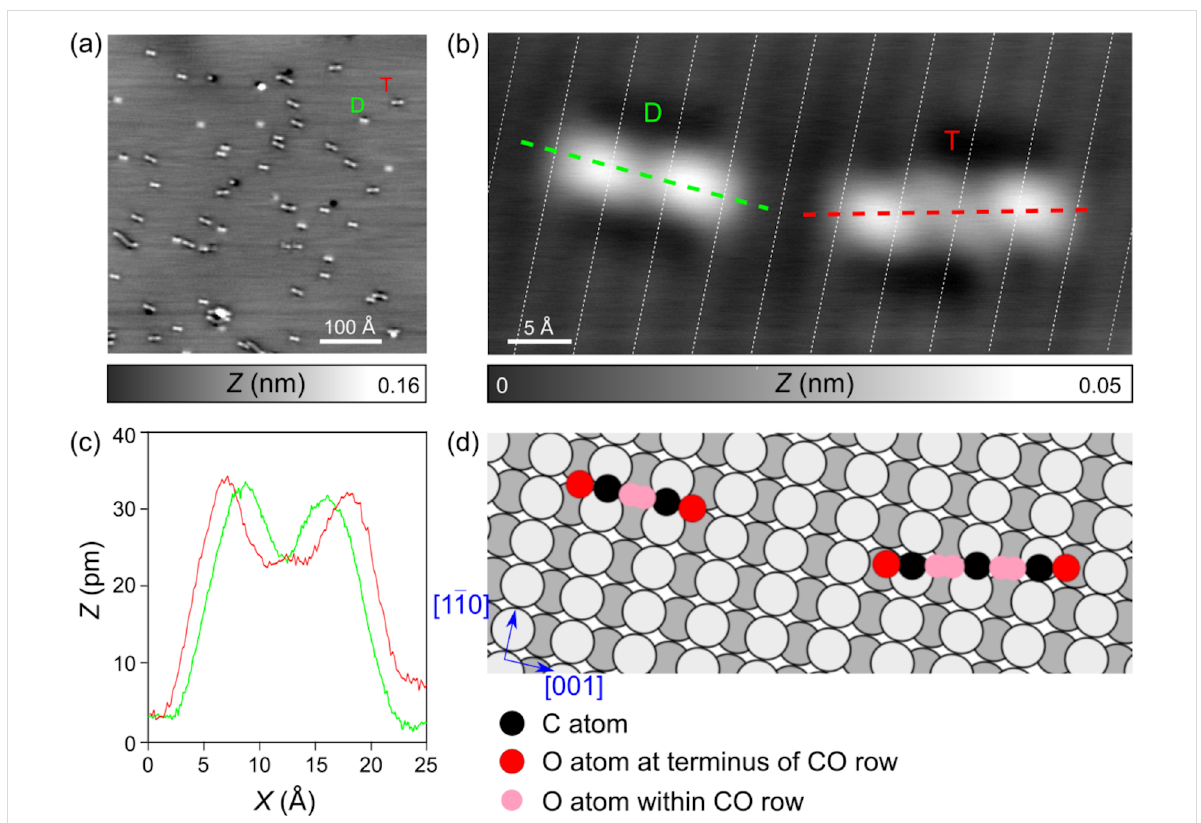
Figure 2: Adsorption of carbon monoxide (CO) molecules on Pb(110). (a) STM overview image of Pb(110) after adsorption of CO molecules (D: dimer, T: trimer, V t = − 0.5 V, I t = 0.5 pA). (b) Closed-up STM image of a CO dimer and trimer ( V t = − 0.1 V, I t = 1 pA). (c) Profiles taken along the dashed lines of panel (b). (d) Sphere model of CO adsorbed on Pb(110). The CO molecules are standing up with protruding and tilted oxygen atoms (red, when tilted to the chain terminus; pink, when tilted to the center of the CO chain), white and dark gray spheres refers to the topmost and down- most Pb atoms of the Pb(110)